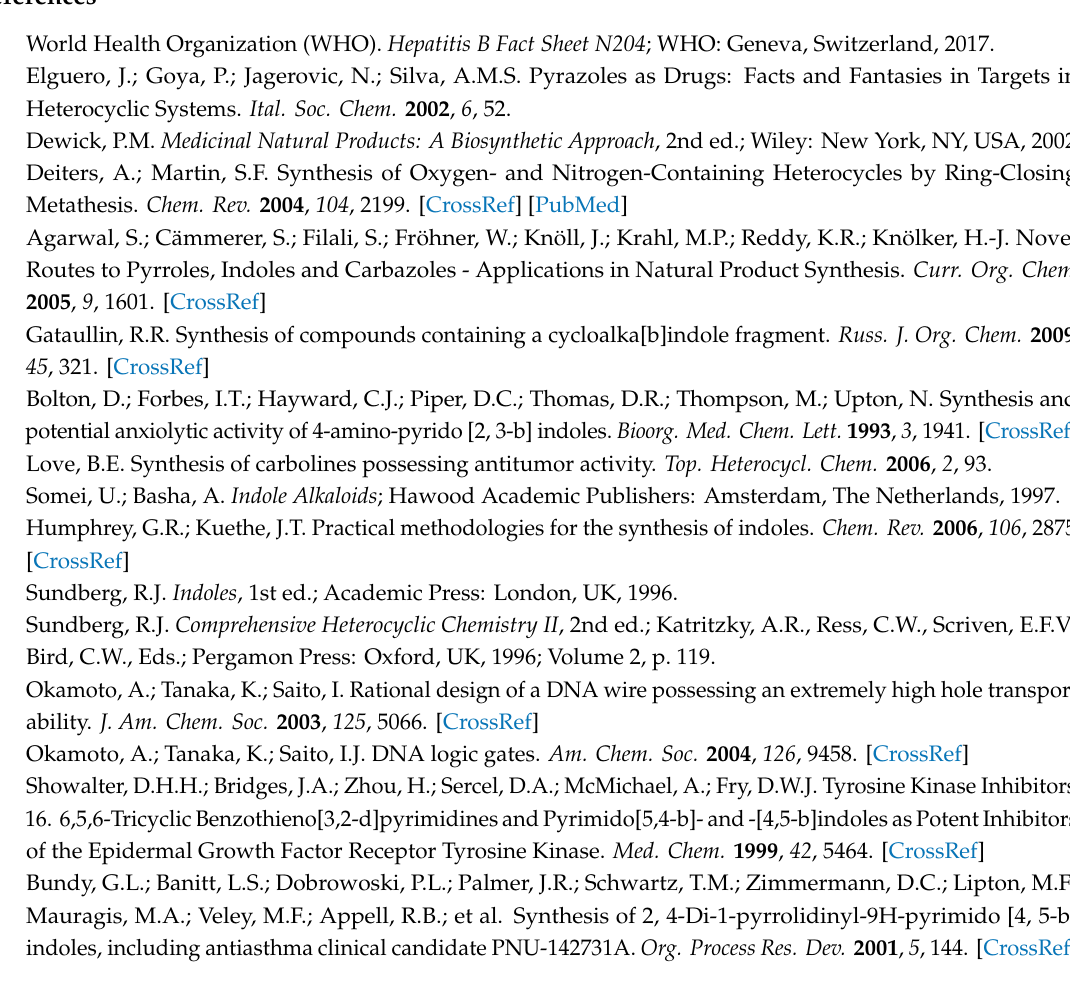
Figure S1: UV / Vis spectrum of the title compound (3) (MeOH, M 0.0116 mmol / l, optical cell 1.0 cm), Figure S2: IR spectrum of the title compound (3) (KBr pellet), Figure S3: 19F NMR (376.72 MHz, DMSO-d6) spectrum of the title compound (3), Figure S4: 13C NMR (75.48 MHz, DMSO-d6) spectrum of the title compound (3), Figure S5: 1H NMR (300.16 MHz, DMSO-d6) spectrum of the title compound (3), Figure S6: LC / MS Data for